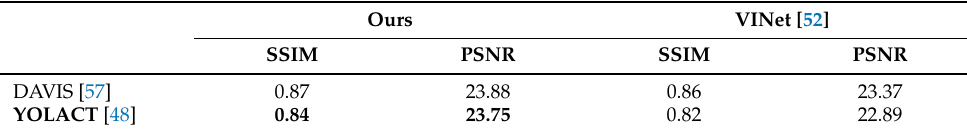
Table 2. Performance comparisons between our model and